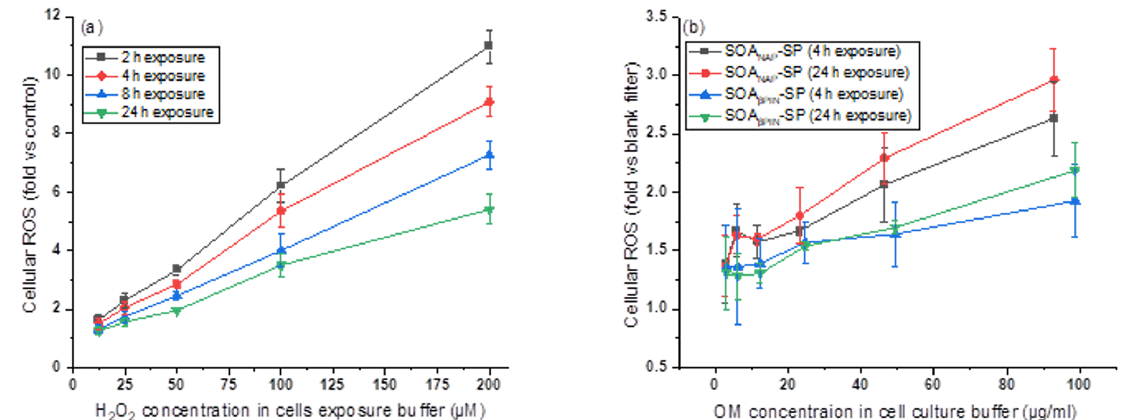
Figure 11. Fold changes of ROS production caused by exposing A549 cells (a) to H 2 O 2 and (b) to particle extracts. Panel (a) shows that the fold change of cellular ROS increased with an increase in the H 2 O 2 concentration but decreased with increasing exposure time (e.g., from 2 to 24h the cellular ROS production decreased by a factor of 2 at 100µM H 2 O 2 exposure). In contrast, panel (b) shows that the fold change of cellular ROS production, caused by exposing cells with particle extracts, increased with an increase in exposure time from 4 to